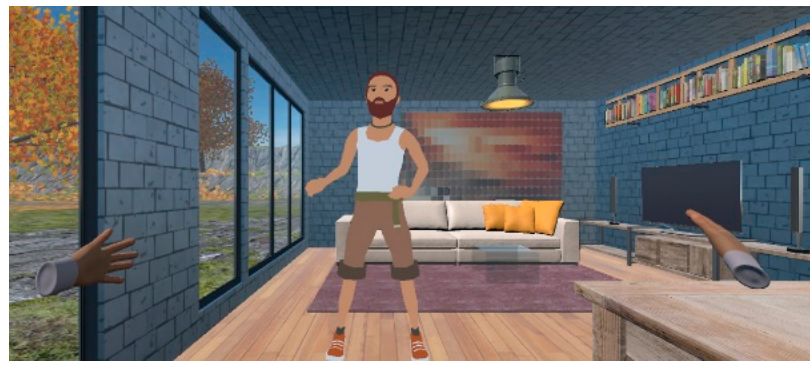
Figure 5. User using RVM-IVRSA.